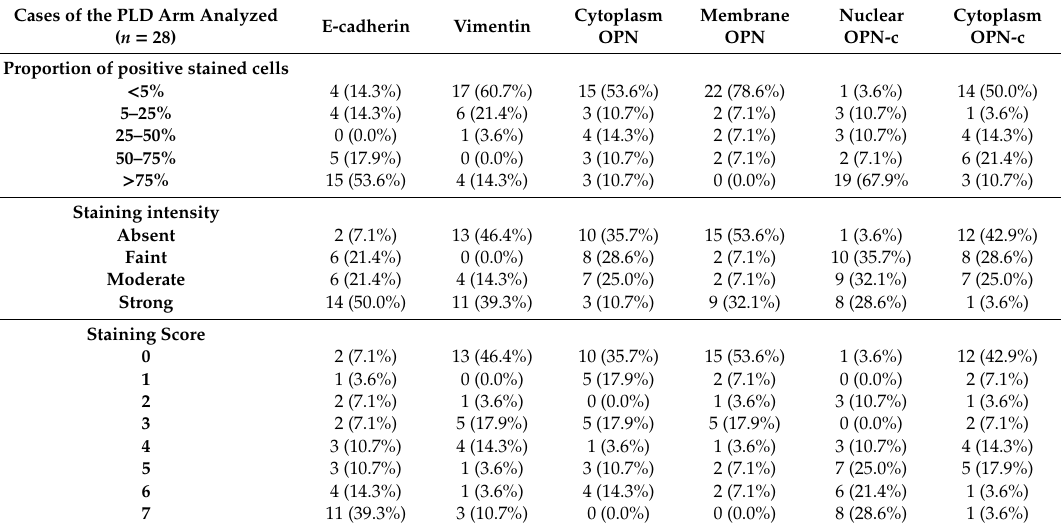
Table 4. IHC staining intensity and proportion of positive stained tumor cells for E-cadherin, vimentin, OPN, and OPN-c in the PLD-treated